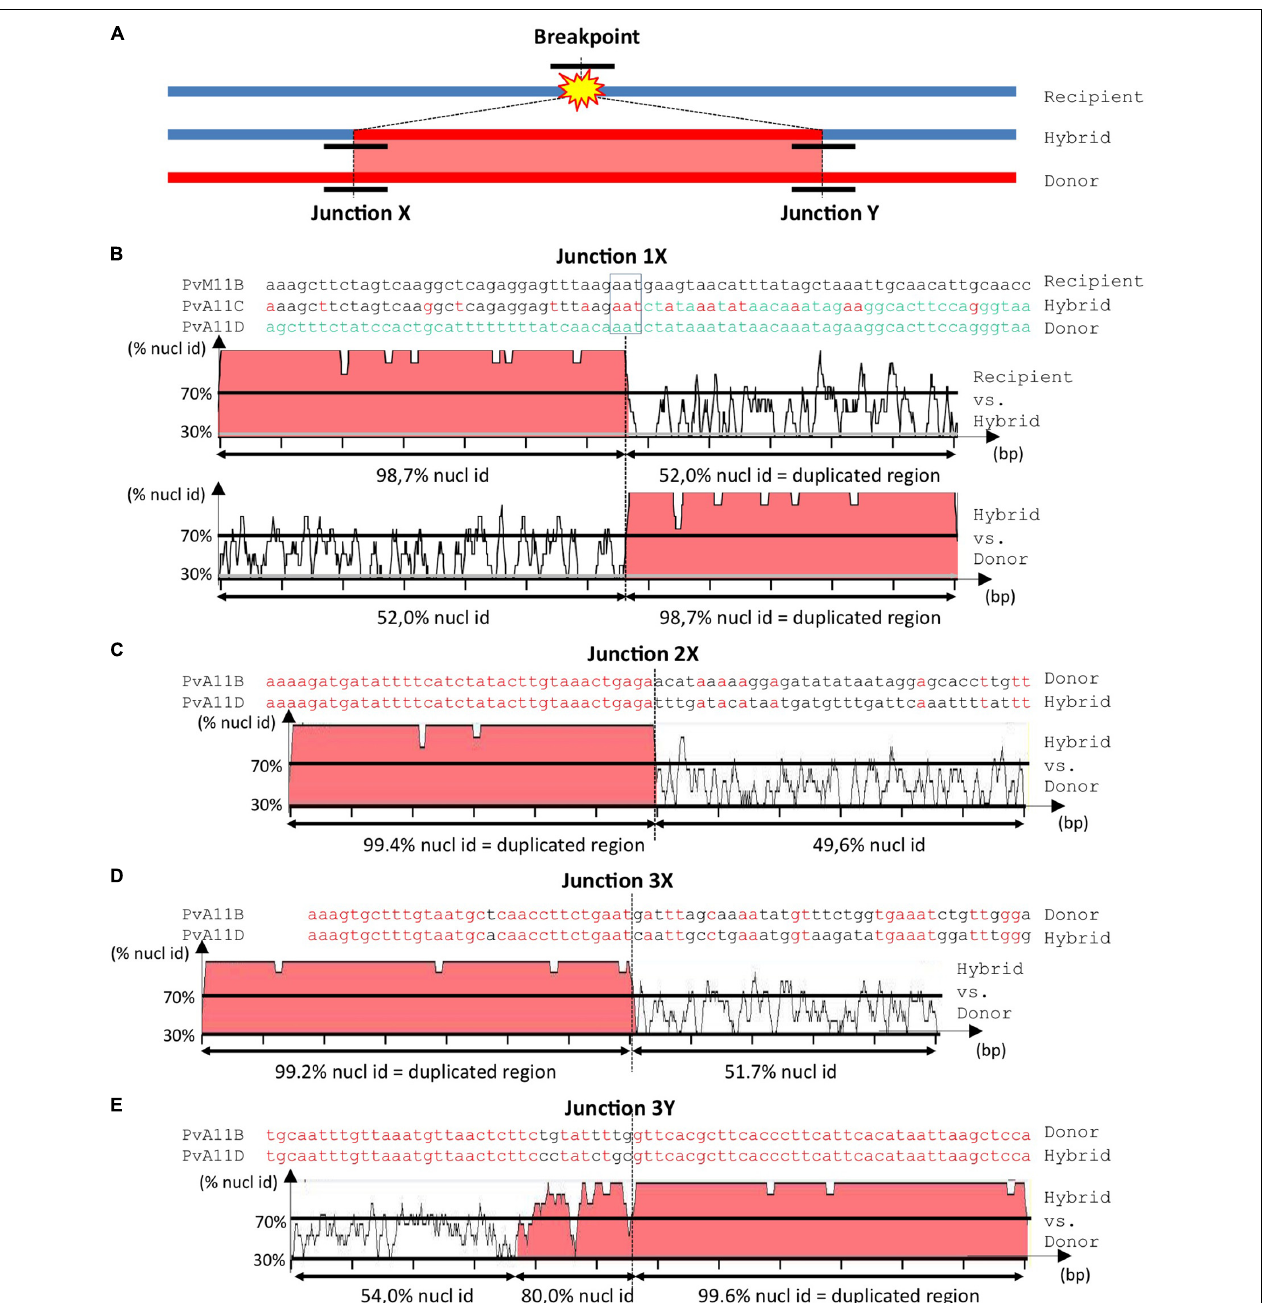
FIGURE 4 | Analysis of junctions from SD‘ events at Co-2 subtelomeric region of chromosome 11 long arm. (A) Simplified summary model describing the resulting stages of a SD event. The double-strand break occurs somewhere in the recipient (blue) molecule. Before repair, partial digestion of the breakpoint borders may occur, leading to loss of sequence. During the repair process, there is a duplicative invasion of the recipient molecule by the donor (red) molecule. Black short lines represent the regions that has to be aligned to accurately resolve the junctions (X and Y) between the broken molecule (recipient) and the duplicated region (donor), resulting in the final hybrid molecule. For more detailed information on double-strand break repair models, please refer to Puchta (2005) and Fiston-Lavier et al. (2007). (B–E) Nucleotide alignment at junctions 1X, 2X, 3X, and 3Y, respectively. Sequences are named according to their corresponding contigs. Aligned matching bases are red. For larger-scale vizualization, the 1000 bp surrounding region was analyzed using mVISTA (Mayor et al., 2000) after indels removal. Identity between sequences is indicated in %. Regions with identity equal or above 70% in 10bp windows are filled in red. Note that when the hybrid molecule is retained in the progeny, the recipient molecule is lost and a putative recipient molecule has to be found in another genotype to help resolving the breakpoint event. Therefore in (B) we used PvM11B contig from BAT93 genotype to help resolving junction 1X from an SD that occurred between PvA11B and PvA11C contigs in G19833 genotype. For junctions 2X (C) , 3X (D) and 3Y (E) , the recipient was not retrieved in BAT93, therefore the junctions are a bit less accurately resolved, but it was sufficient to infer the associated repair mechanism (i.e., NHEJ or HR).